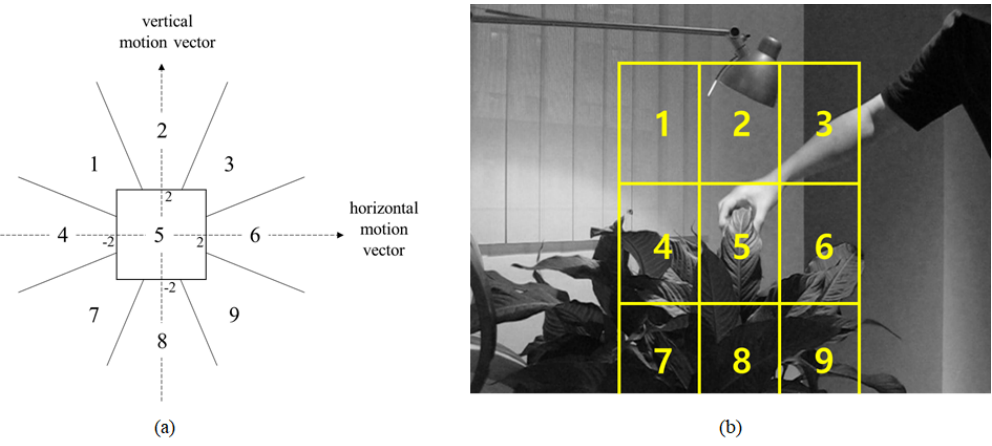
Figure 6. ( a ) 9 regions of motion vectors. ( b ) Each search window associated with each region of motion